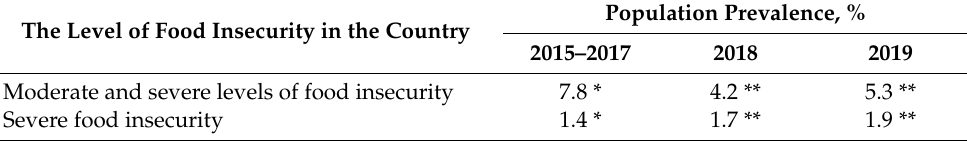
Table 1. The level of food insecurity among the population of the Republic of Kazakhstan (source: FAO, WHO, 2018; * and Bureau of National Statistics of the Agency for Strategic Planning and Reforms of the Republic of Kazakhstan **).